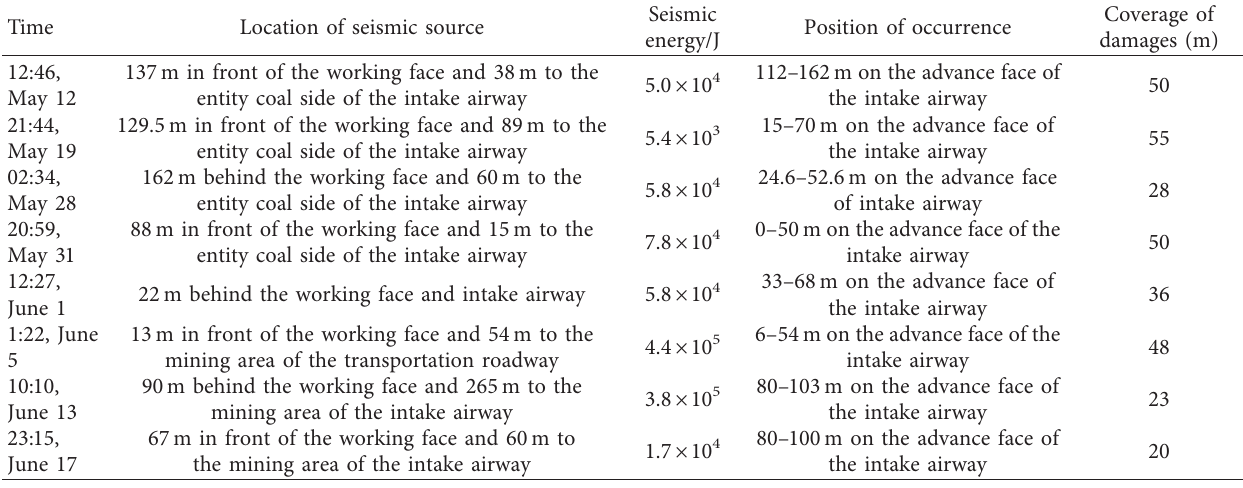
Table 1: Statistic of rock burst events.